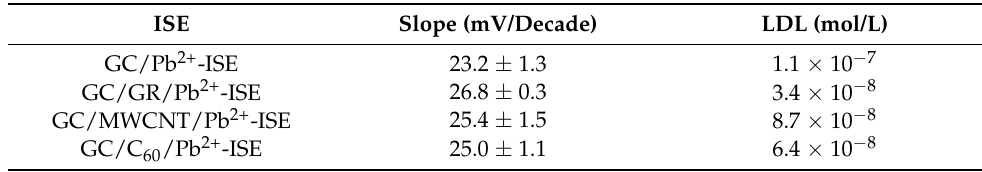
Figure 6. Potentiometric response time of different Pb 2+ ‐ ISEs in the range of Nernstian response. 3.4. Stability and Conductivity of ISEs In the practical measurements, the stability of ISE has great influence on the accuracy due to the drift of potential. Multi ‐ circle cyclic voltammetry scan was performed in a 0.1 M KCl solution. The 20 ‐ circle scan curves of each electrode have only slight offset as shown in Figure 7; hence, the prepared electrodes display good stability. In Section 2.2, the carbon ‐ based nanomaterials dispersion is easy to prepare. However, there are some defects in the dispersion uniformity, which are also consistent with the morphologies of SEM. In the 10 − 5 mol/L lead solution, GC/GR/Pb 2+ ‐ ISE and GC/MWCNT/Pb 2+ ‐ ISE were